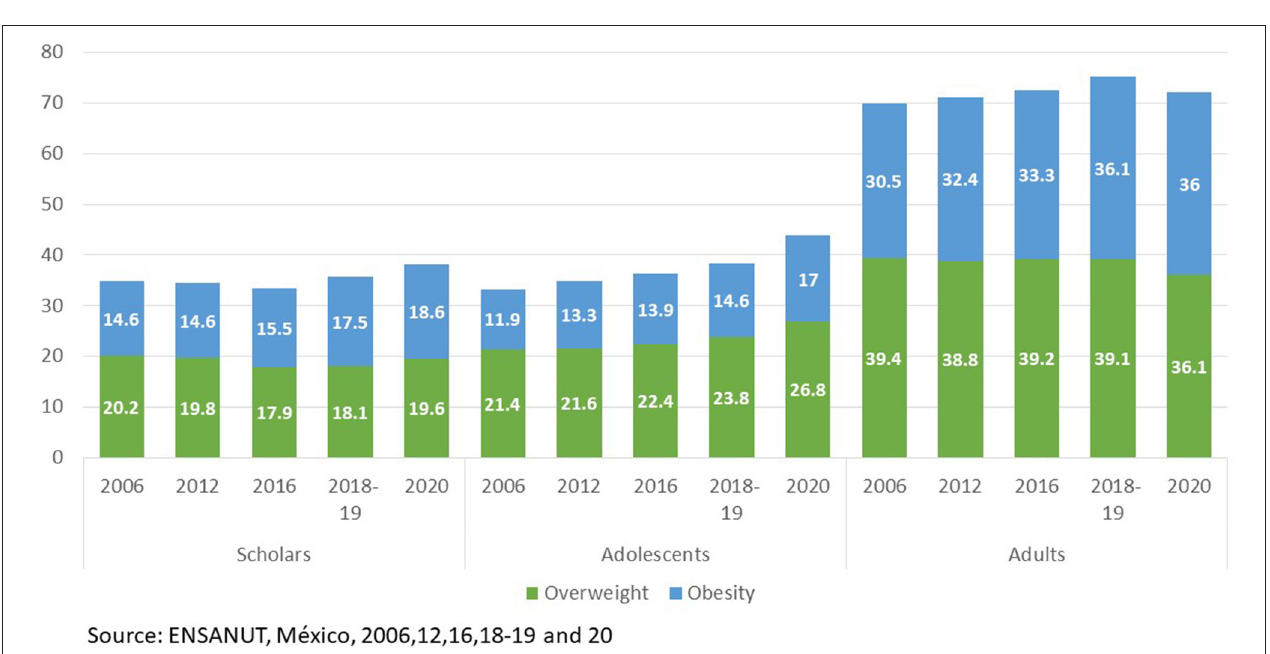
Frontiers in Nutrition |